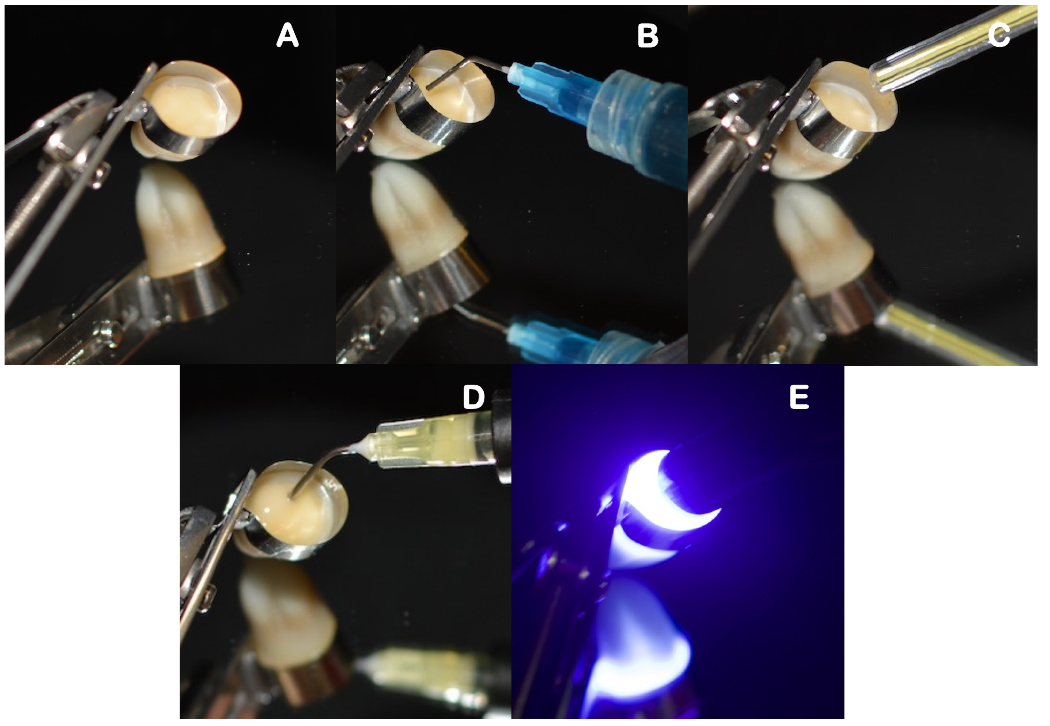
Figure 3. Restorative procedure of the etch-only group, where: ( A ) is the application of restorative matrix band, ( B ) etching protocol, ( C ) rinsing and drying step, ( D ) application of the flowable self-adhesive composite, and ( E ) light curing of each increment.